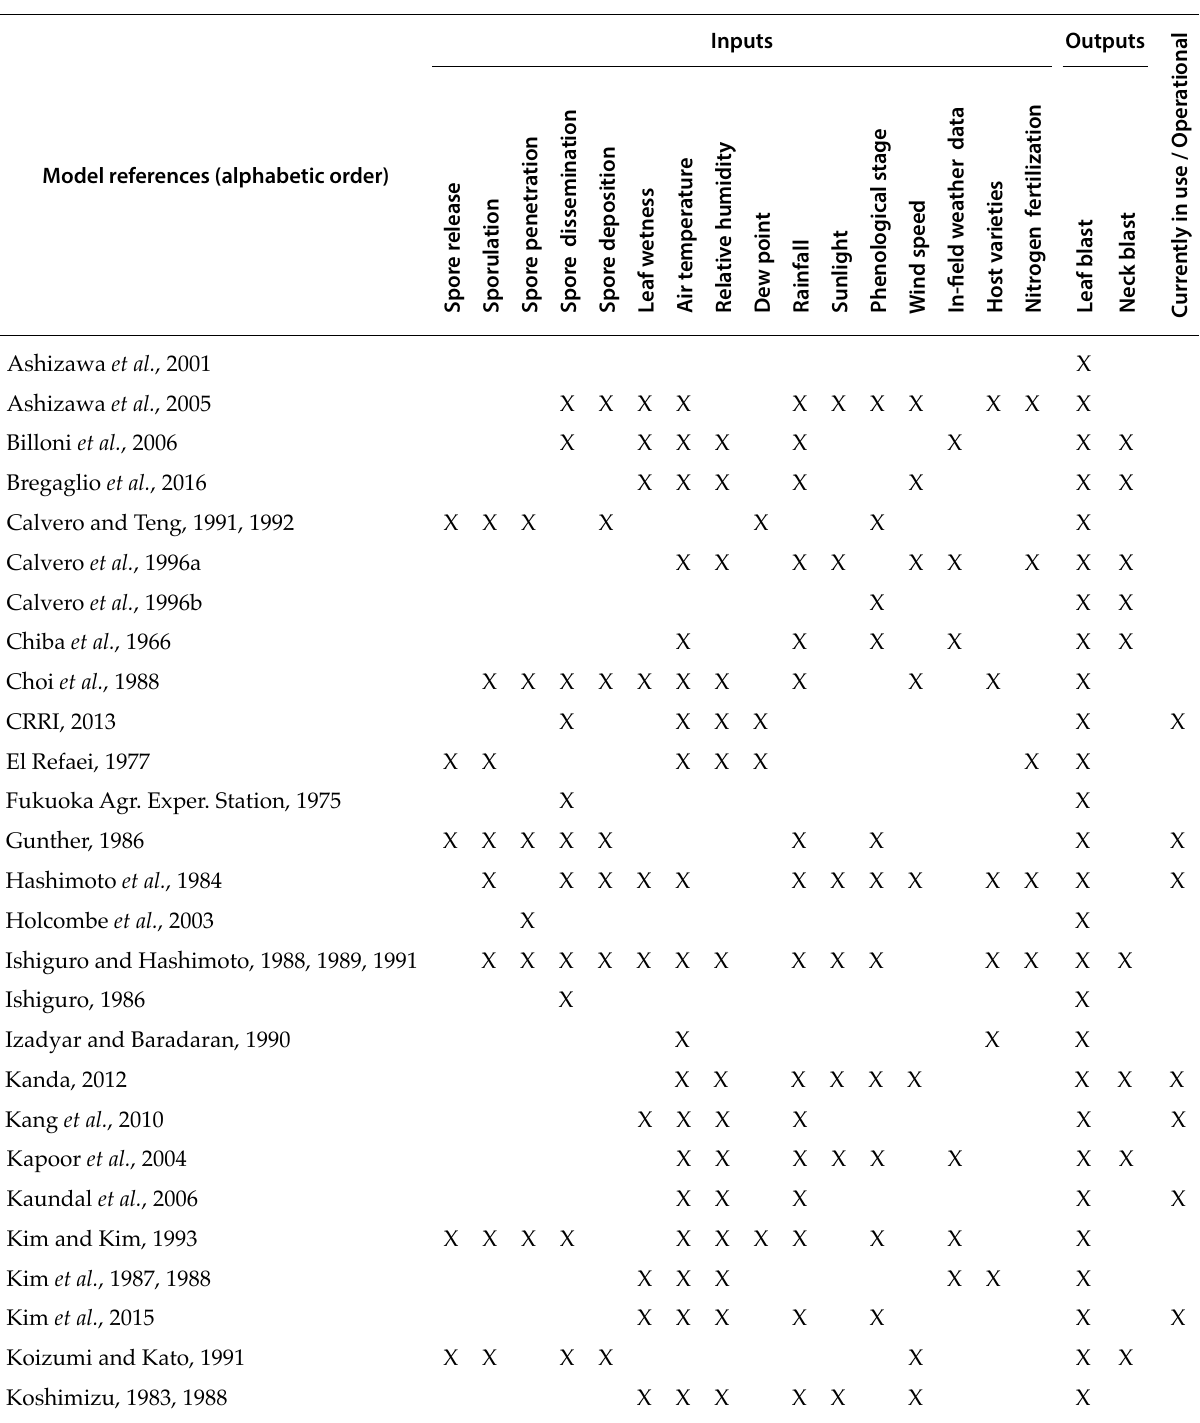
Table 2. Characteristics of 52 reviewed rice blast forecasting models, including their input variables, outputs and current